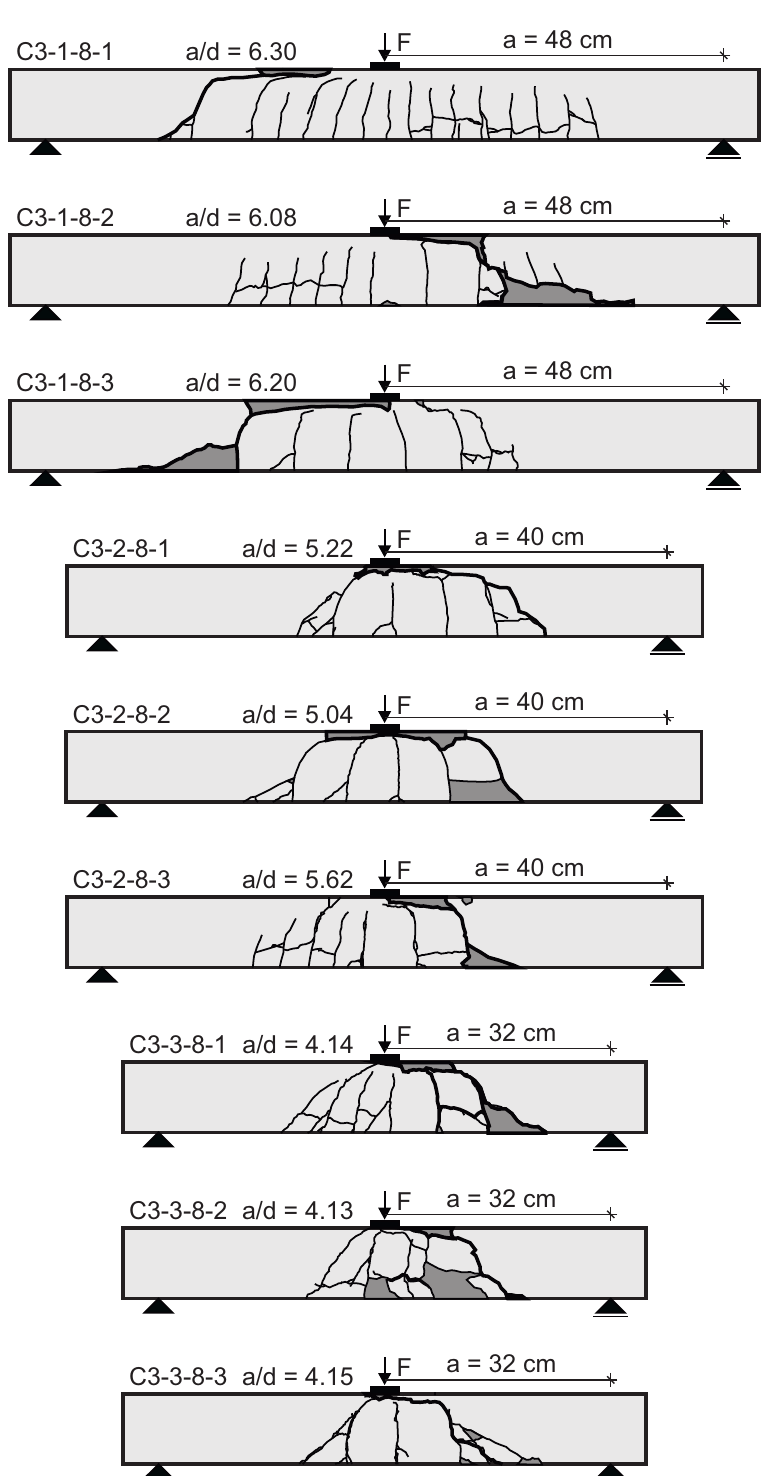
Figure 6. Crack pattern and failure mechanism for d = 8 cm shear test series.